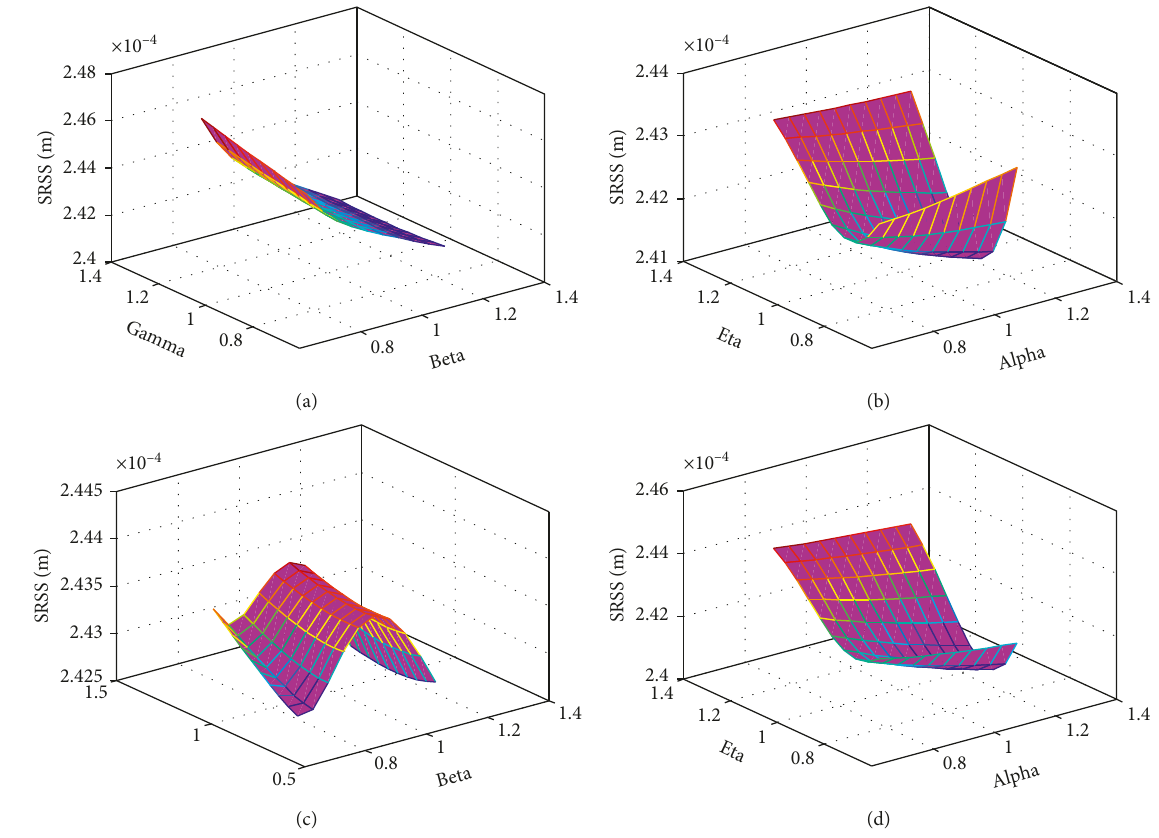
Figure 9: Comparison of numerical results depending on installation location ( μ � 0 . 03) of nodes 10 and 15 and 10 and 13. (a) SRSS of case 1 when α � 1 . 414, β � 1 . 15, c � 0 . 95, and η � 1 . 0; (b) SRSS of case 2 when α � 1 . 15, β � 1 . 15, c � 0 . 95, and η � 0 . 85; (c) SRSS of case 1 when α � 1 . 122, β � 1 . 15, c � 0 . 9, and η � 1 . 0; (d) SRSS of case 2 when α � 1 . 15, β � 1 . 15, c � 0 . 9, and η � 0 .